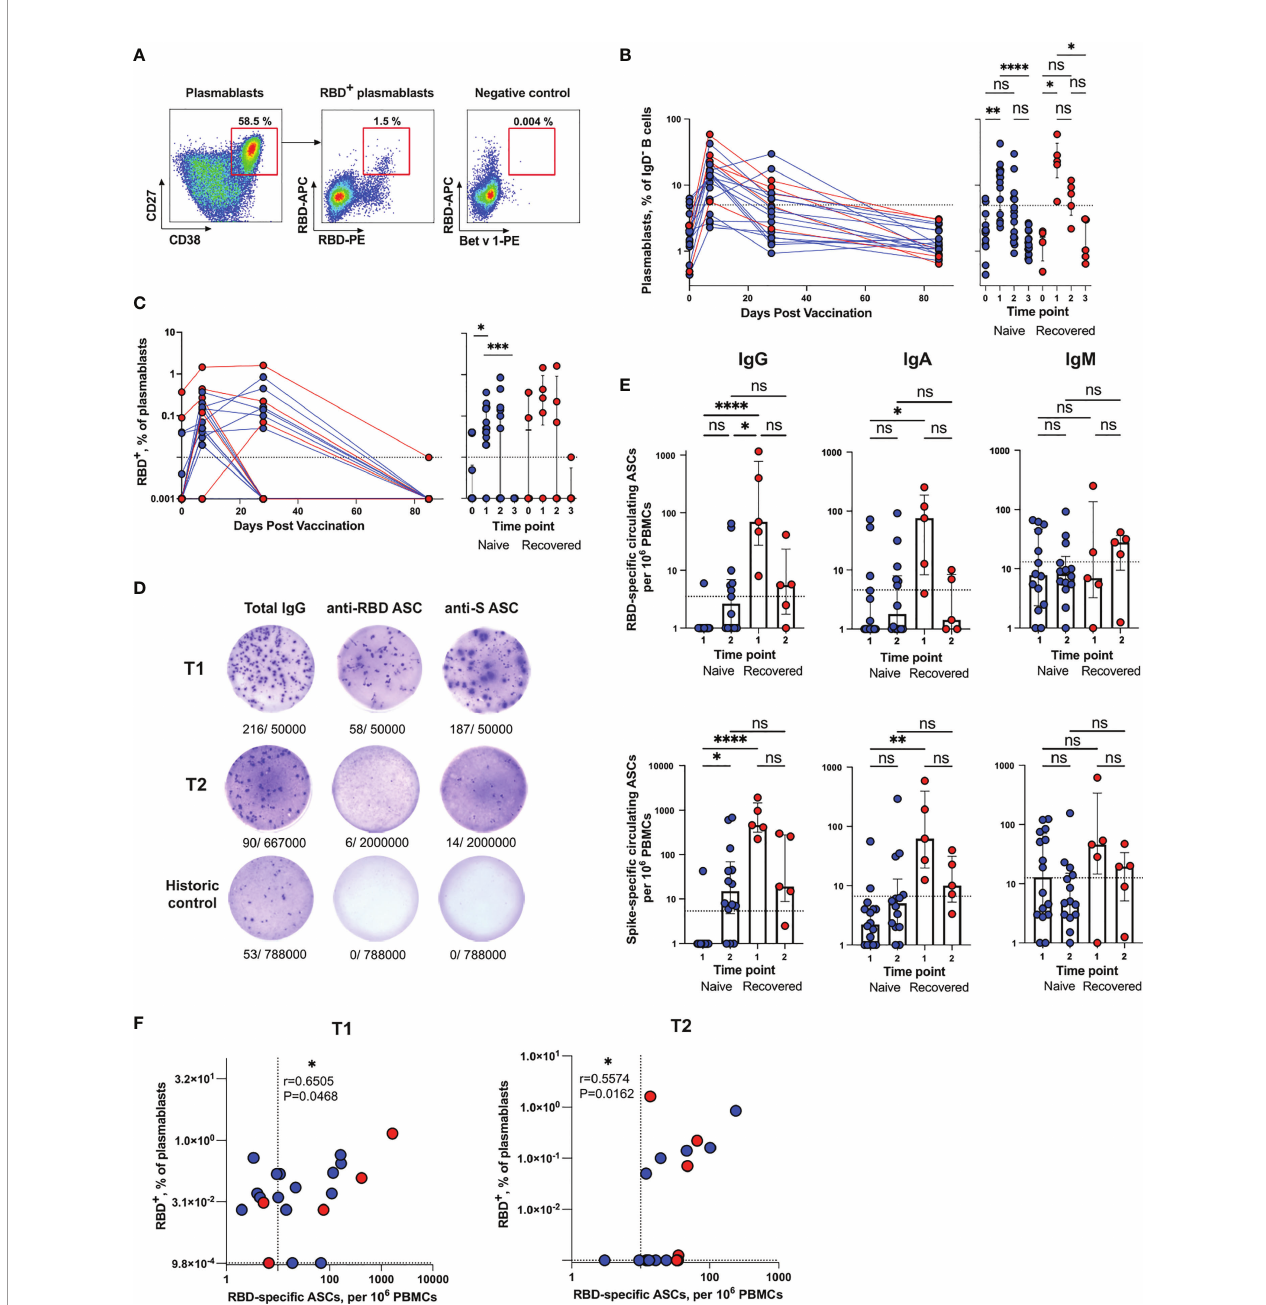
FIGURE 2 | Quanti fi cation of total and RBD-speci fi c plasmablasts in blood samples from Sputnik V-vaccinated individuals. (A) Representative fl ow cytometry dot plots showing the gating strategy for measuring the percentage of total (left panel) and RBD + (middle panel) plasmablasts. As a negative control, sample stained with an irrelevant protein Bet v 1 is shown (right panel). Numbers inside the plots indicate the percentage of events speci fi c to respective gates. (B, C) Dynamic changes in total (B) and RBD + (C) plasmablast frequencies in samples collected at different time points. (D) Representative ELISpot images for measuring the frequencies of circulating total (left), anti-RBD (middle) or anti-S (right) IgG ASCs. Numbers below the wells represent the frequencies of ASCs relative to the total number of cells in the well. (E) Frequencies of circulating IgG (left column), IgA (middle column) or IgM (right column) ASCs speci fi c for RBD (upper row) or S (bottom row) antigens per 10 6 PBMCs collected from vaccinated individuals at different time points. The dotted lines indicate the threshold for positive antigen-speci fi c ASC responses. (F) Spearman ’ s correlation between RBD-speci fi c (IgG + IgA + IgM) ASCs and the levels of RBD + plasmablasts at T1 (left) and T2 (right) time points. Results are shown for individual samples (symbols) from naïve (n = 17) and recovered (n = 5) recipients. Data are presented as median ± IQR. Asterisks indicate signi fi cant difference between groups determined using the Kruskal – Wallis test, *P < 0.05, **P < 0.01, ***P < 0.001, ****P < 0.0001, ns, not signi fi cant. ACS, antibody-secreting cell; IQR, interquartile range; RBD, receptor-binding